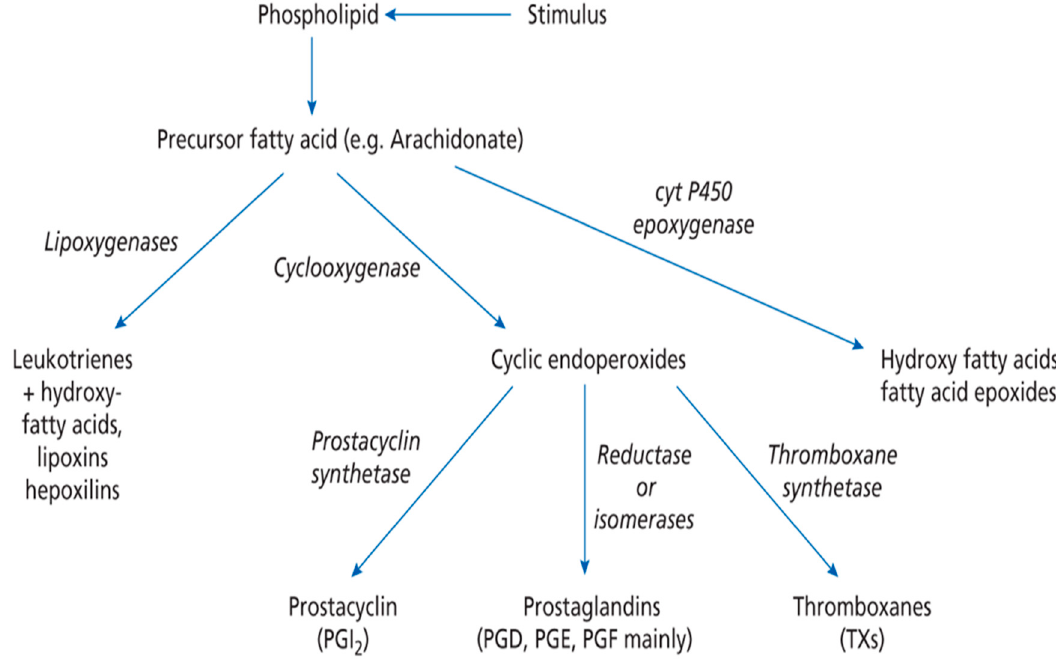
Figure 2. Overall pathway for the conversion of essential fatty acids into eicosanoids. Taken from [1], with permission. Lipids: Biochemistry, Biotechnology and Health , 6th ed. Gurr, M.I.; Harwood, J.L.; Frayn,